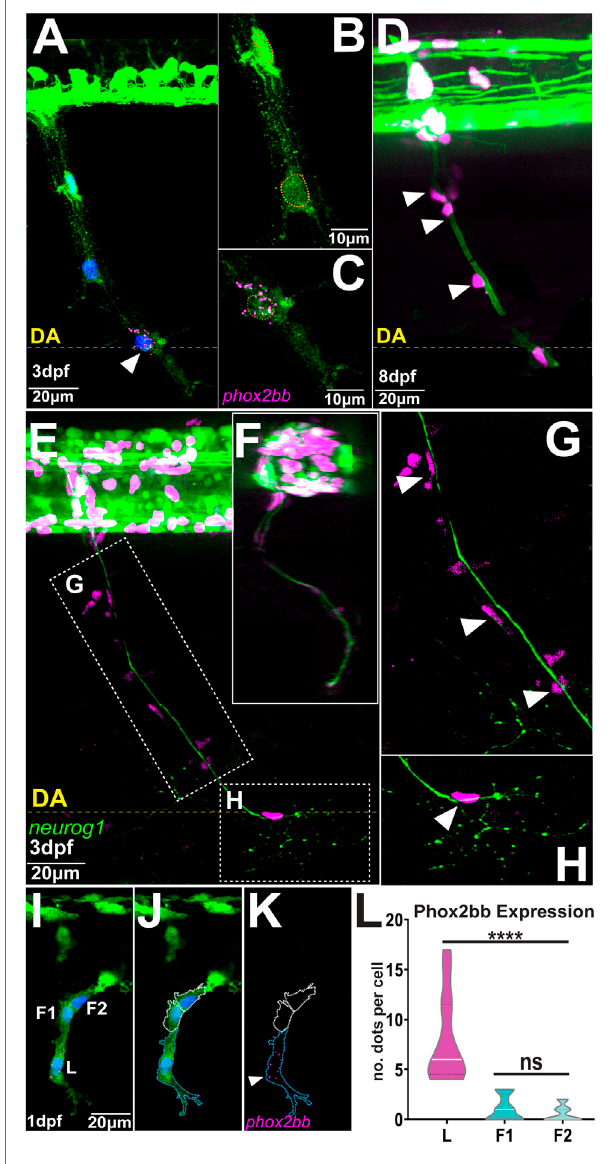
FIGURE 2 | Phox2bb is predominantly expressed in leader cells (A – C) phox2bb expression at 3dpf (B) Enlargements offollower and (C) leadercells. Sox10 in green, phox2bb in magenta and nuclei in blue in panel A and highlighted with orange dotted lines in B-C (D) Confocal image of Sox10:mG embryo at 8dpf. White arrowheads indicate TNC cells showing Schwann cell morphology (E – H) Confocal images of Sox10:mG; neurogenin1:GFP at 3dpf showing sensory neuron axon extension from DRG to SCG lateral view in (E) and transversal section in (F) (G) Enlargement showingTNCfollowerslocalisingaroundtheaxoninpositionofSchwanncells indicatedbywhitearrowheadsand (H) Enlargementshowingsingleleadercell in the position of SCG (I – K) Confocal image of Sox10:GFP embryo at 1dpf showing expression of phox2bb in leader cell. L: Leader, F1 and F2: fi rst and second followers. White arrowheads indicate leader. Blue and white dotted lines mark the outlines of leader and follower cells respectively (L) Quanti fi cation of phox2bb expression (n = 14 chains; Welch ’ s t test, L vs. F1 and F2 p < 0.0001, F1 vs. F2 p = 0.2566). Anterior to the left, dorsal top. DA: Dorsal